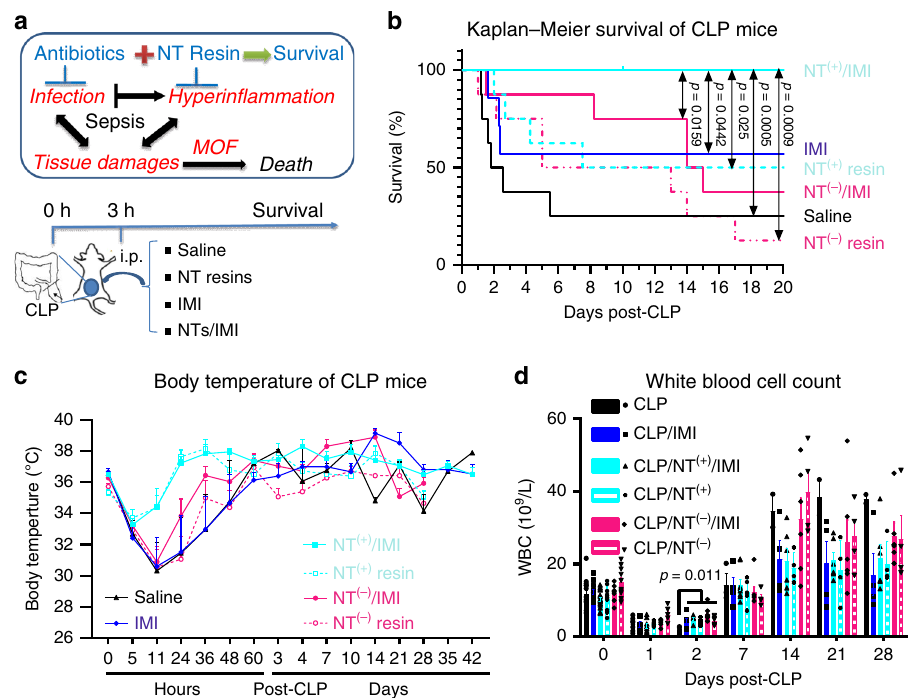
Fig. 6 Sepsis treatment via TD NT resins. a Schematic illustration of the mechanism of sepsis associated with multiple organ failure (MOF) and death driven by both infection and hyperin fl ammation and our therapeutic strategy by combining antibiotics and immune modulation via NT resin scavenging to control both infection and hyperin fl ammation through i.p. implantation on day 3 post-CLP in mouse sepsis models. b The survival of CLP mice ( n = 8, except for IMI group, n = 7) treated with NT ( − ) PEGA-(OAC17) 4 or NT ( + ) PEGA-(ArgC17) 4 3 h post CLP with or without antibiotics imipenem/cilastatin (IMI, 50/50 mg per kg body weight) treatments. As a result, the combination of IMI and NT ( + ) provides a 100% survival by treating both infection and hyperin fl ammation. After 1 week post CLP, animals in NT ( − ) and NT ( − ) /antibiotic groups were continuously sacri fi ced upon severe necrotic abscess observed (statistical signi fi cance was analyzed by Log-rank (Mantel – Cox) test, and a signi fi cant level of 0.05 was used for comparison). c The reduced hypothermia and fast body-temperature recovery were observed in the groups treated with NT ( + ) w/wo IMI. d The white blood cells (WBC) were monitored for the survived CLP mice in the above treatments over 4 weeks ( n = 8), and reduce over time as shown in b . Signi fi cant low WBC was observed in CLP control group on day 2, and stable white blood cell counts were observed in NT ( + ) /IMI treatment groups with all mice survived (mean ± SEM, statistical signi fi cance was measured by unpaired one-sided Student ’ s test, and a signi fi cant level of 0.05 was used for comparison). Source data are available in the Source Data fi